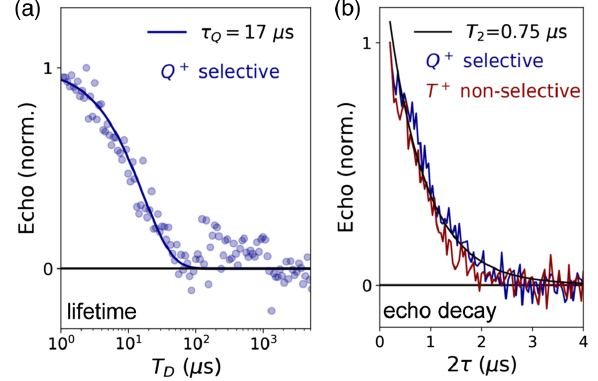
FIG. 3. Quintet spin lifetime and coherence for quintet and triplet states. (a) Selective measurement of the quintet lifetime at the Q þ transition with an exponential fit to a quintet lifetime of τ ¼ 17 (cid:2) 1 μ s. (b) Echo decay measurement for quintet and Q triplet states ( Q þ and T þ transitions, respectively) along with an exponential fit with T 2 ¼ 0 . 75 (cid:2) 0 . 02 μ